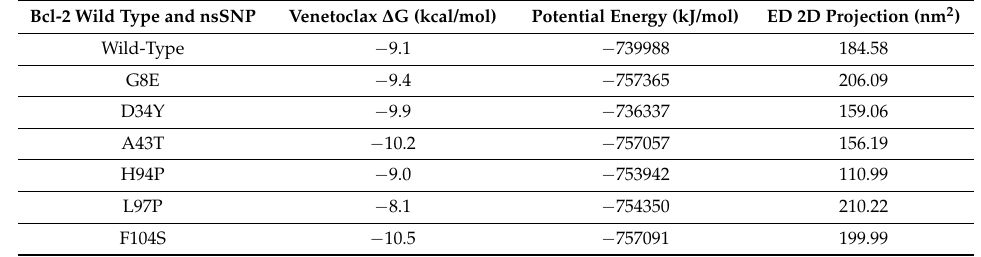
Table 1. List of Bcl-2 nsSNP under study and corresponding binding free energy, potential energy and essential dynamics analysis from the Auto Dock Vina [52] and MD simulations,